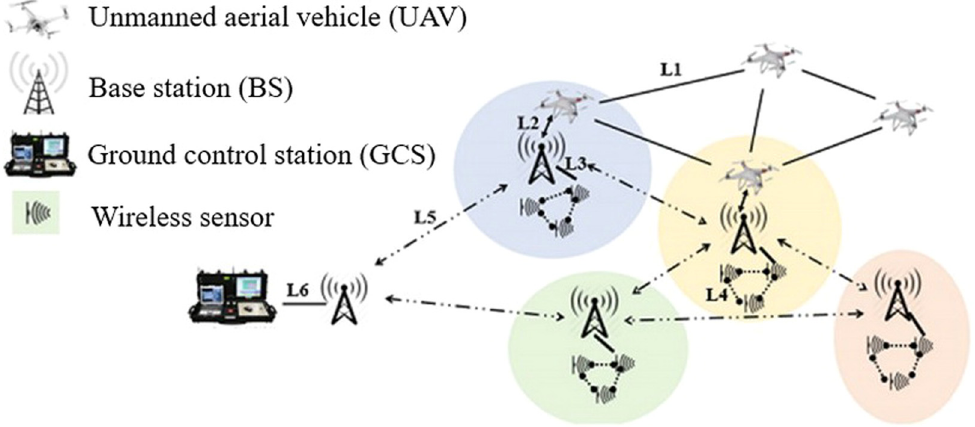
Figure 1: The monitoring architecture of several UAVs [ 20 ]